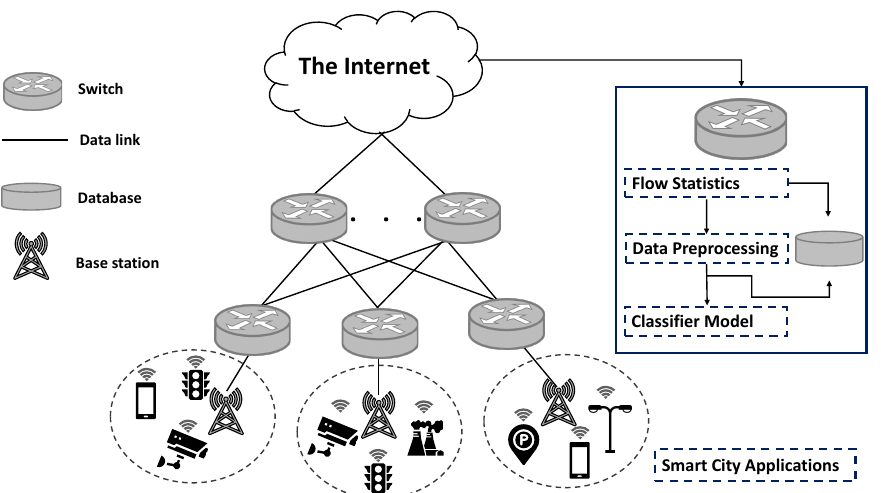
Figure 2. Typical scenario illustrating traffic classification based on machine learning in a smart city